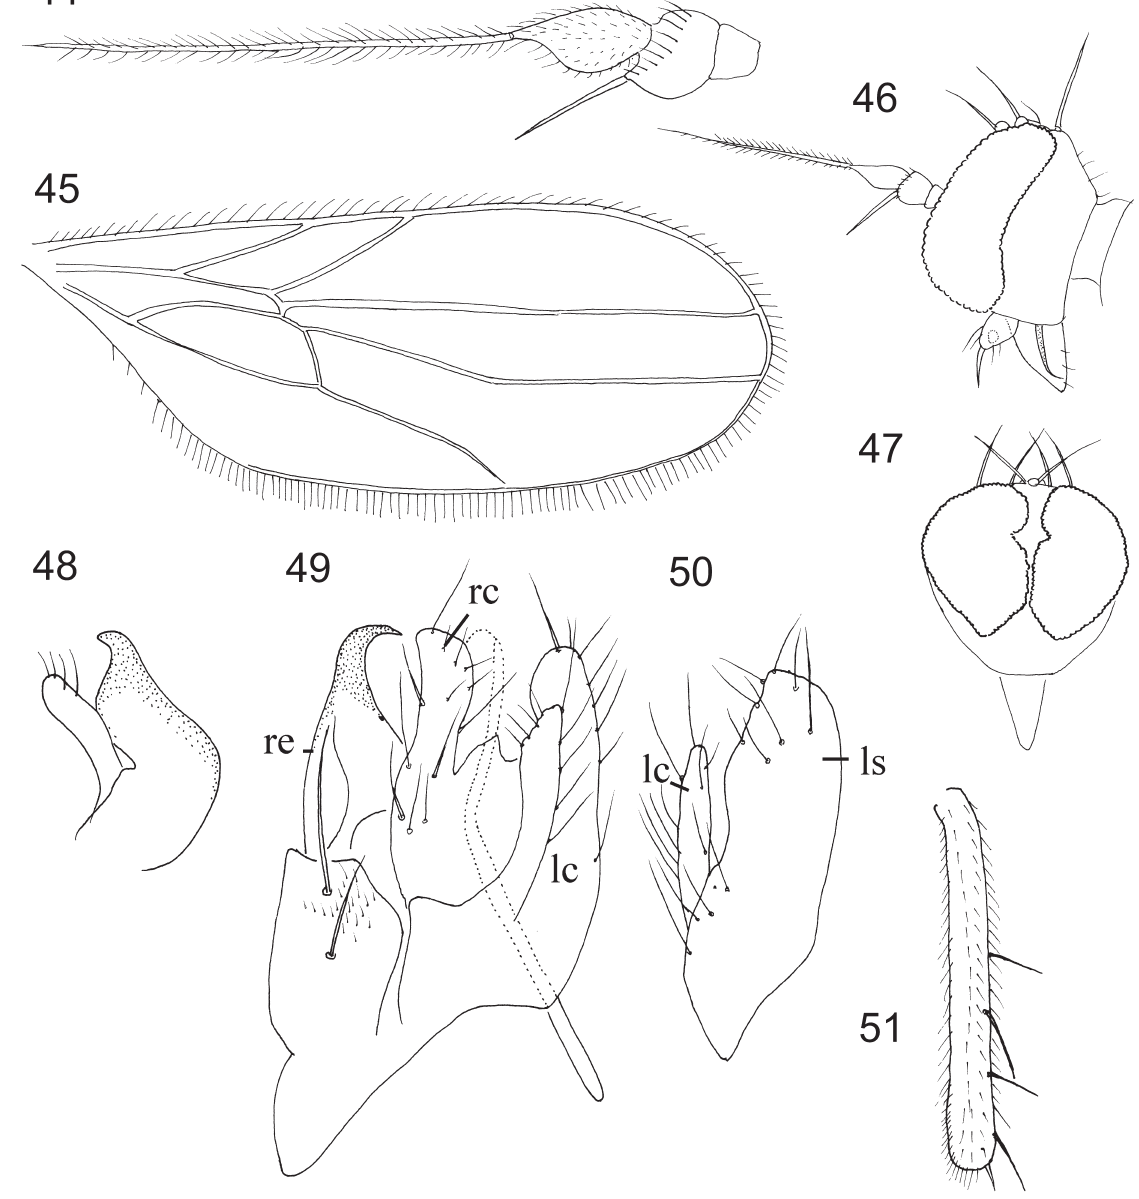
Figs 44-51. Chersodromia sylvicola sp. nov., ♂. 44 . antenna, lateral view. 45 . wing, dorsal view. 46 . head, lateral view. 47 . head, frontal view. 48 . right epandrial lamella, lateral view. 49 . epandrium with cerci, dorsal view. 50 . left surstylus, lateral view. 51 . hind tibia, anterior